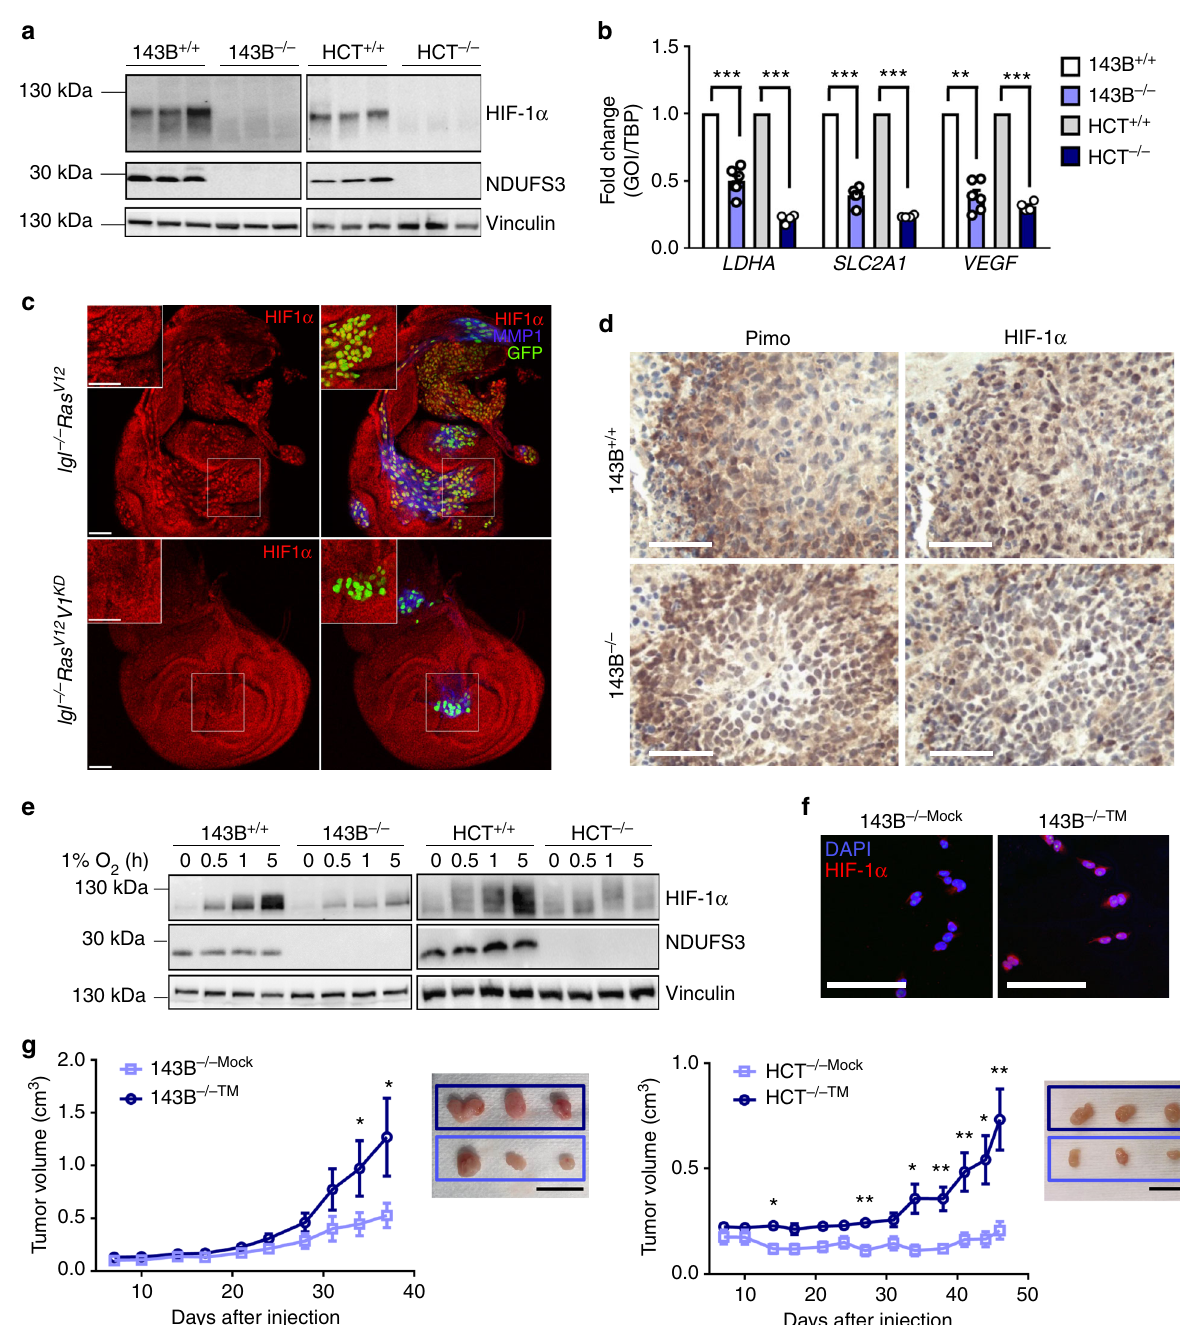
Fig. 3 CI de fi ciency promotes HIF-1 α destabilization. a HIF-1 α and NDUFS3 western blot analysis in 143B and HCT xenografts. Vinculin was used as loading control. b Gene expression of HIF-1 α targets evaluated by qRT-PCR in 143B [ n = 8, df = 14, t ( LDHA ) = 6.5, t ( SLC2A1 ) = 4.5, t ( VEGF ) = 4.7] and HCT [ n = 4, df( LDHA ) = 6, t ( LDHA ) = 14.1, df( SLC2A1 ) = 3, t ( SLC2A1 ) = 9.3, df( VEGF ) = 6, t ( VEGF ) = 11.7)] xenografts. For SLC2A1 in HCT cells the Student ’ s t -test assuming unequal variance was applied. Data are mean + s.e.m. c Immuno fl uorescence for HIF-1 α and MMP1 in Drosophila wing discs. Tumor tissue is composed of GFP + cells. Representative images are shown. Scale bars: 40 µ m. d Immunohistochemical staining of pimonidazole (Pimo)-labeled protein adducts and HIF-1 α in 143B + / + and 143B − / − tumors of equivalent volume (2 cm 3 ). Representative images are shown. Scale bars: 50 µ m. e HIF-1 α and NDUFS3 western blot of 143B and HCT cells cultured in 1% O 2 at indicated times. Vinculin was used as loading control. f Immuno fl uorescent staining of nuclei (DAPI) and HIF-1 α in 143B − / − cells carrying empty vector (Mock) or TM-HIF-1 α (TM). Representative images are shown. Scale bars: 100 µ m. g Growth curves in CD-1 nude mice of 143B [ n = 15, df = 28, t (day 37) = 2.2] and HCT [data were log-transformed, n = 7, df = 12, t (day 46) = 3.5] xenografts derived from CI-de fi cient cells carrying empty vector (Mock) or TM-HIF-1 α (TM). Data are mean ± s.e.m. Representative tumors are shown. Scale bars: 2 cm. In each panel, statistical signi fi cance is speci fi ed with asterisks (* p < 0.05, ** p < 0.01, *** p <